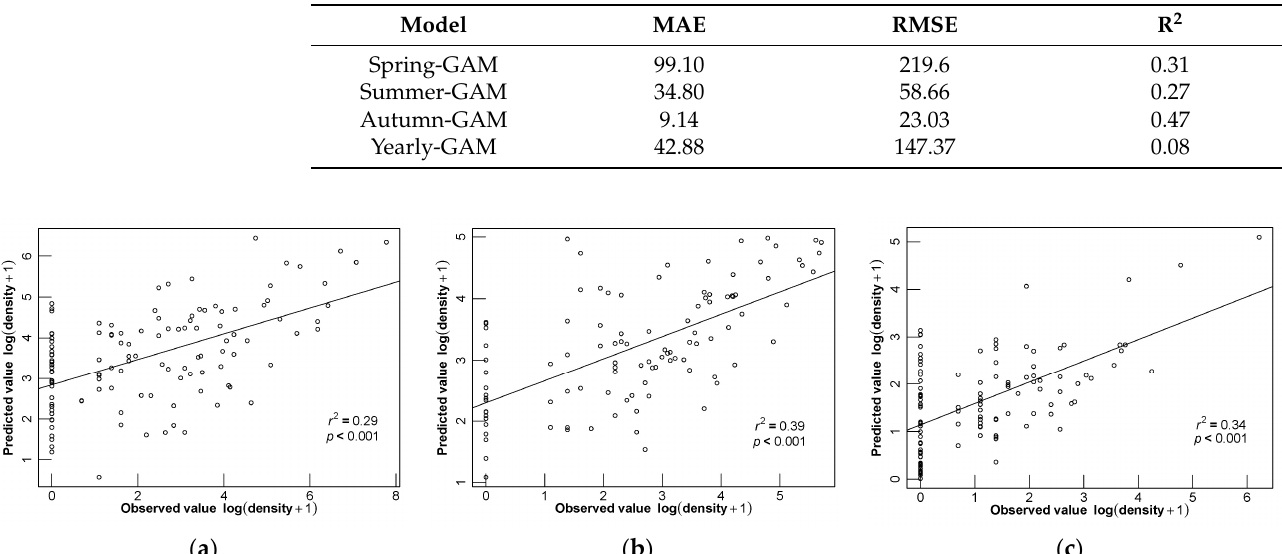
Figure 6. Scatter diagram of observed and predicted densities of D. maruadsi by season. ( a ) Spring; ( b ) Summer; ( c ) Autumn.